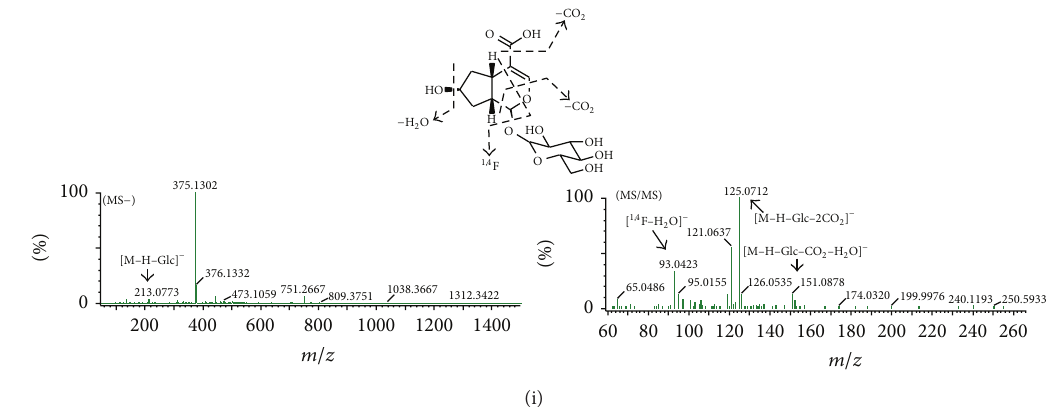
Figure 4: The MS spectra and fragmentation pathway of compound 35 (a), compound 26 (b), compound 8 (c), compound 30 (d), compound 39 (e), compound 61 (f), compound 45 (g), compound 57 (h), and compound 5 (i).